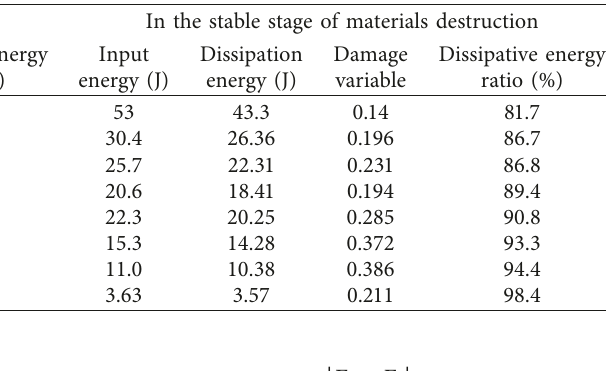
Table 4: Statistics for the damage variable and dissipation energy.